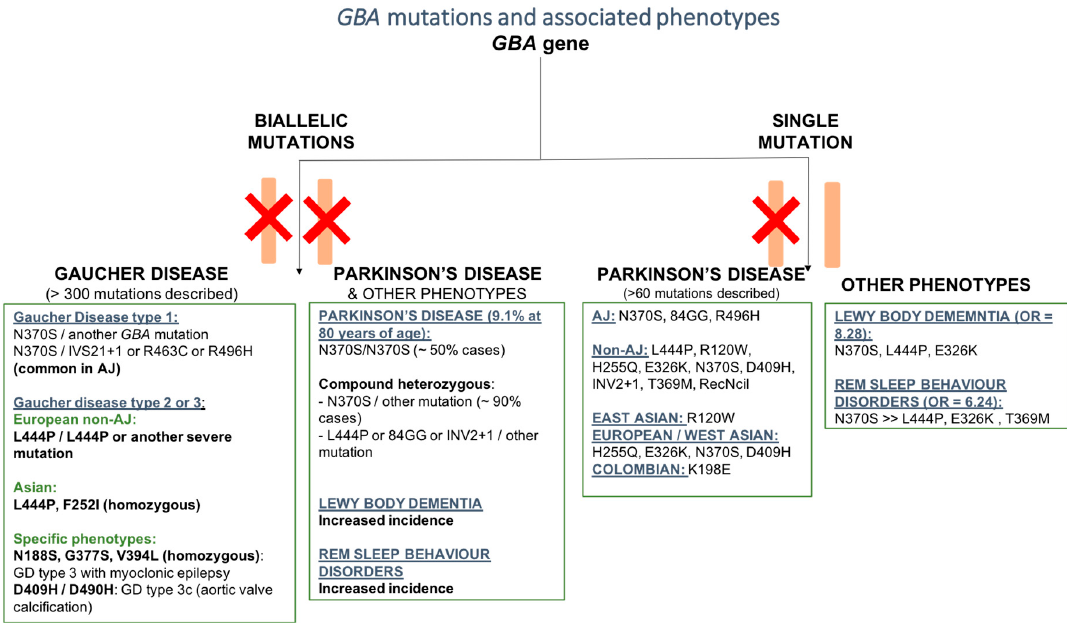
Figure 1. Schematic representation of the most common pathogenic mutations of the GBA genes and associated phenotypes. Phenotypes were grouped based on homozygous and heterozygous mutations, ancestry, and specific associated features.